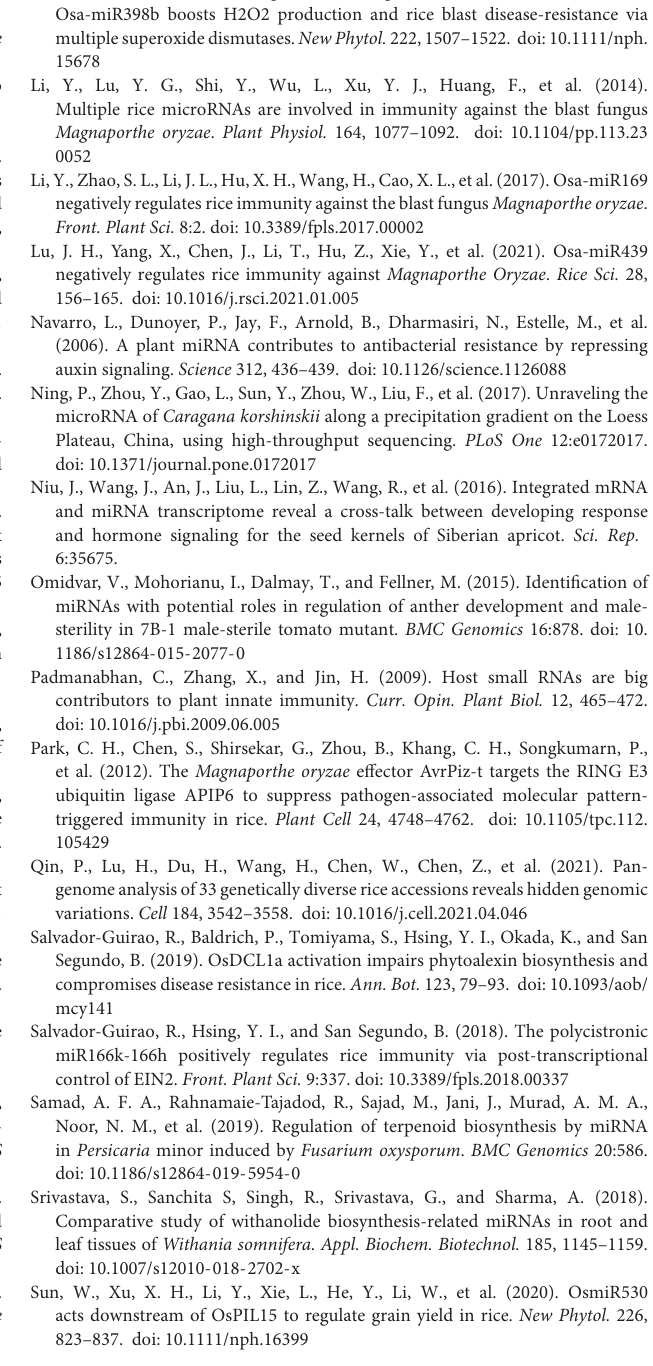
Supplementary Figure 4 | miR530 regulates plant height. (A) Photographs of the gross morphology of the Kasalath control (Ka), OX530, and MIM530 lines planted in paddy yard in Wenjiang District, Chengdu City, Sichuan Province, China during the regular season from April to September in 2019. Scale bars = 50 cm. (B) The